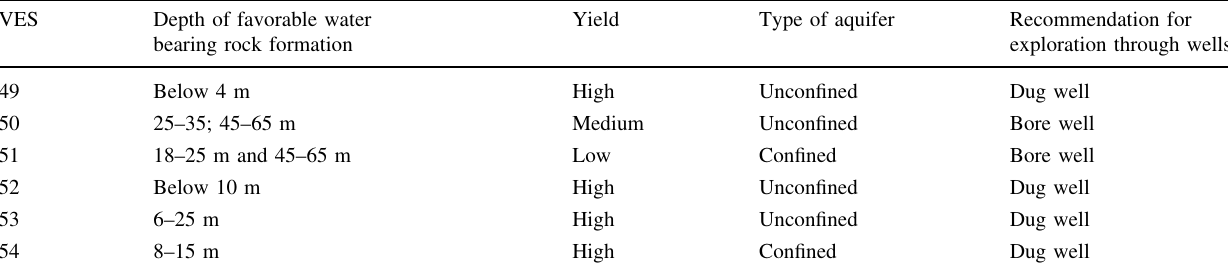
Fig. 8 Representative sounding curves are interpreted as per Orellana and Mooney by Schlumberger methods from Sakri